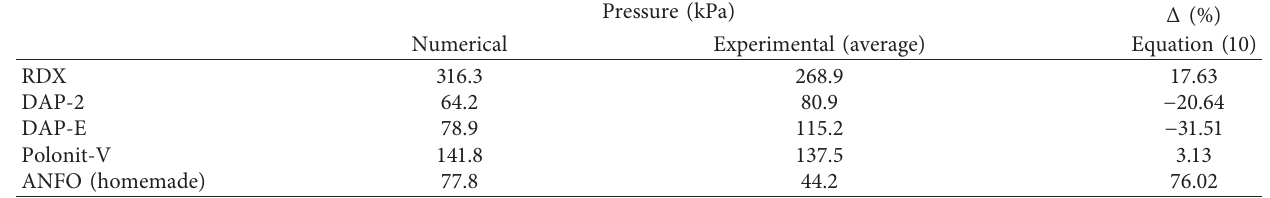
Table 5: Numerically and experimentally derived pressure peaks at 2m from the detonation point.